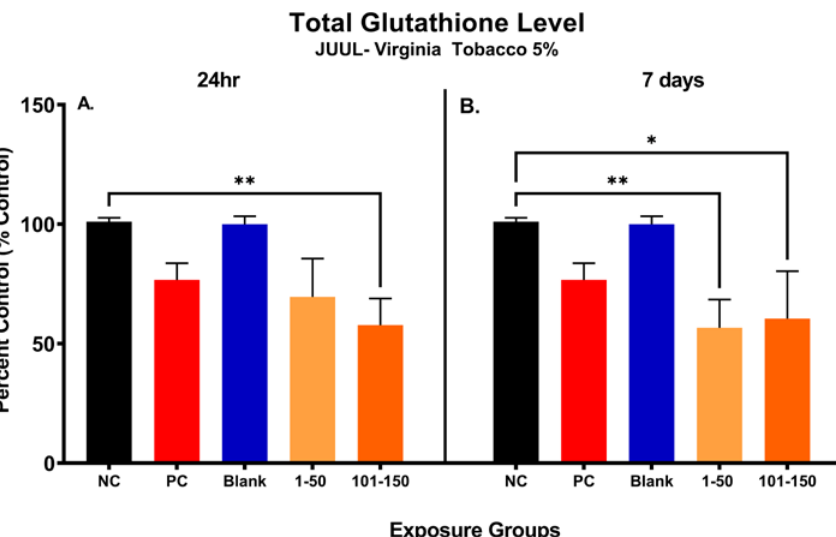
Figure 3. Changes in total glutathione level of pod-type ENDS aerosol exposed SAEC after 24 h and 7 days. The total glutathione level was significantly decreased by 43.25% (**, p < 0.01) in 101–150 puffs after the 24 h exposure to JUUL ® Virginia tobacco 5% ENDS aerosol compared to the negative control ( A ). Even though there was no significance noted, the total GSH level was decreased by 31.44% also in 1–50 puffs at 24 h ( A ). After the 7 days of exposure, the total GSH level has significantly decreased by 44.39% (**, p < 0.01) and 40.50% (*, p < 0.05) in 1–50 puffs and 101–150 puffs, respectively, compared to the negative control ( B ). The Blank control, which contained vehicle solution for dilution, showed no difference compared to the negative control ( B ).